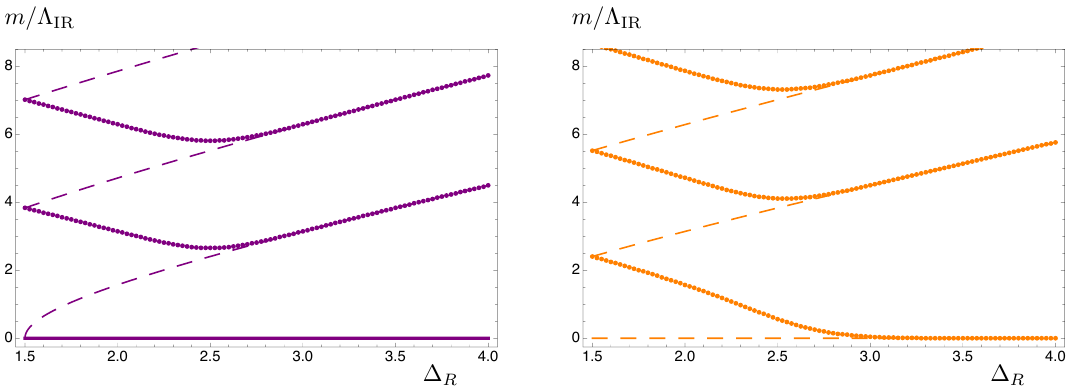
Figure 18 . AdS background. Fermionic spectrum as a function of ∆ R for ˜ λ 0 , IR = ˜ λ (max) . The left 0 , IR and right panels correspond to imposing (+) and ( − ) IR boundary conditions, respectively. The solid line in the left panel indicates the presence of a massless state. The ratio between the UV and IR energy scales is equal to Λ UV = 10 3 . The dashed lines indicate the spectrum of the strongly coupled Λ IR sector in isolation, computed in the limit Λ UV → ∞ , and is the same as the one shown in figure